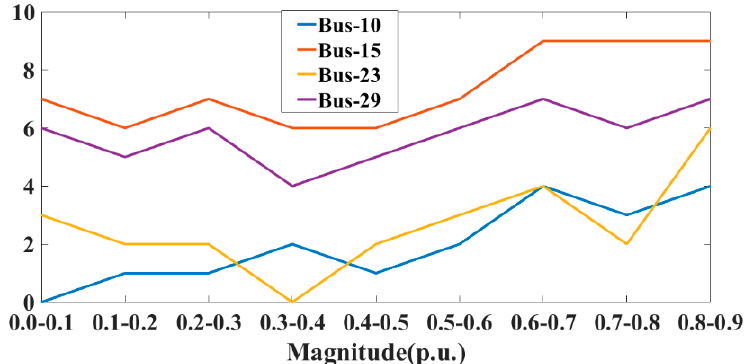
Figure 16. Sags per year for buses 10, 15, 23, and 29 with respect to magnitude. The frequency of sag concerning different types of faults for the same randomly chosen buses, 10, 15, 23, and 29, is shown in Figure 17. It is identified that the maximum and minimum frequencies of sag were due to a single line to ground fault and a three-phase fault, respectively.